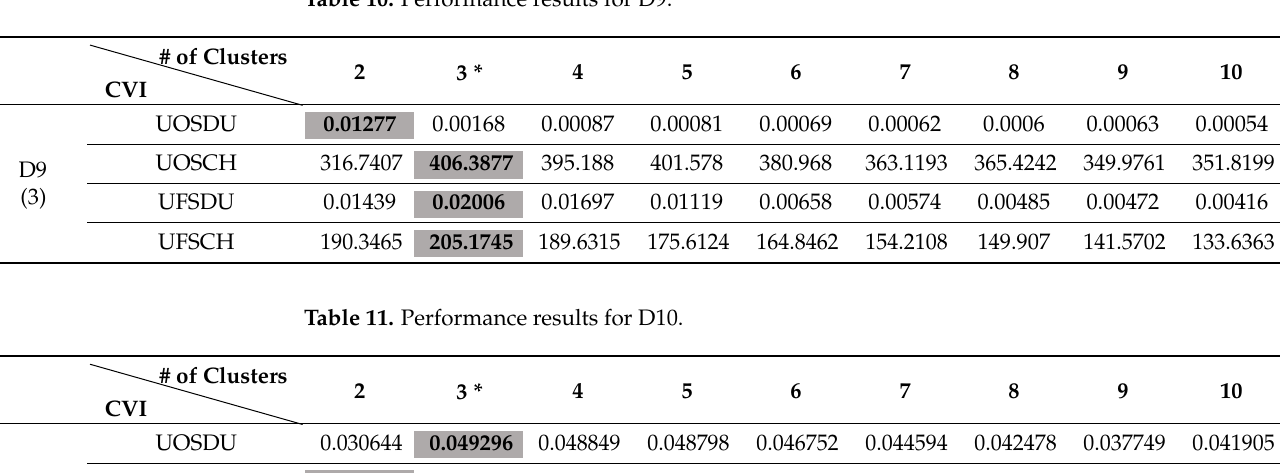
Table 10. Performance results for D9.